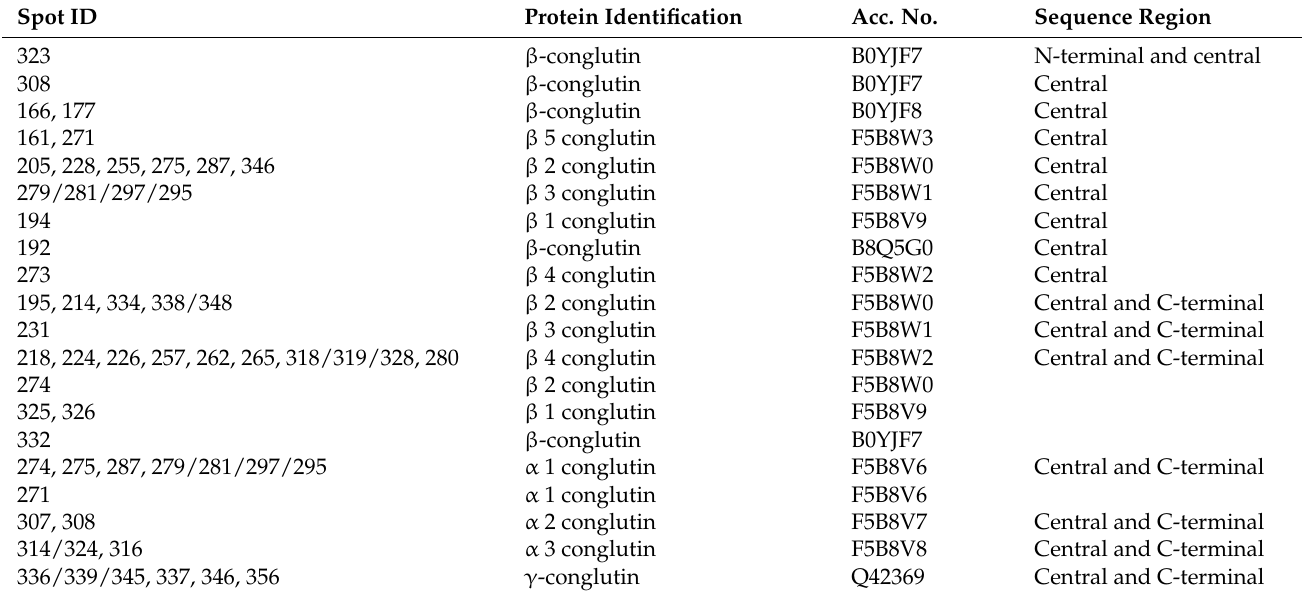
Table 9. List of identified conglutins in Sonet cultivar ( L. angustifolius ). Spots were grouped according to the identified sequence